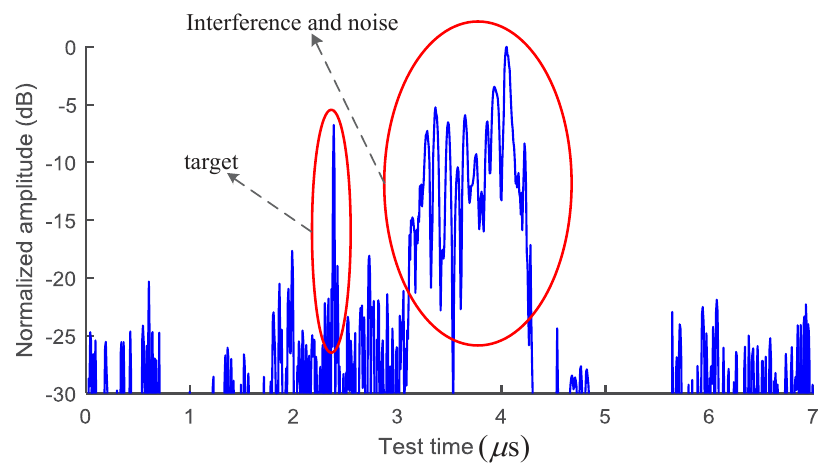
Figure 3. The echoes after SMF and